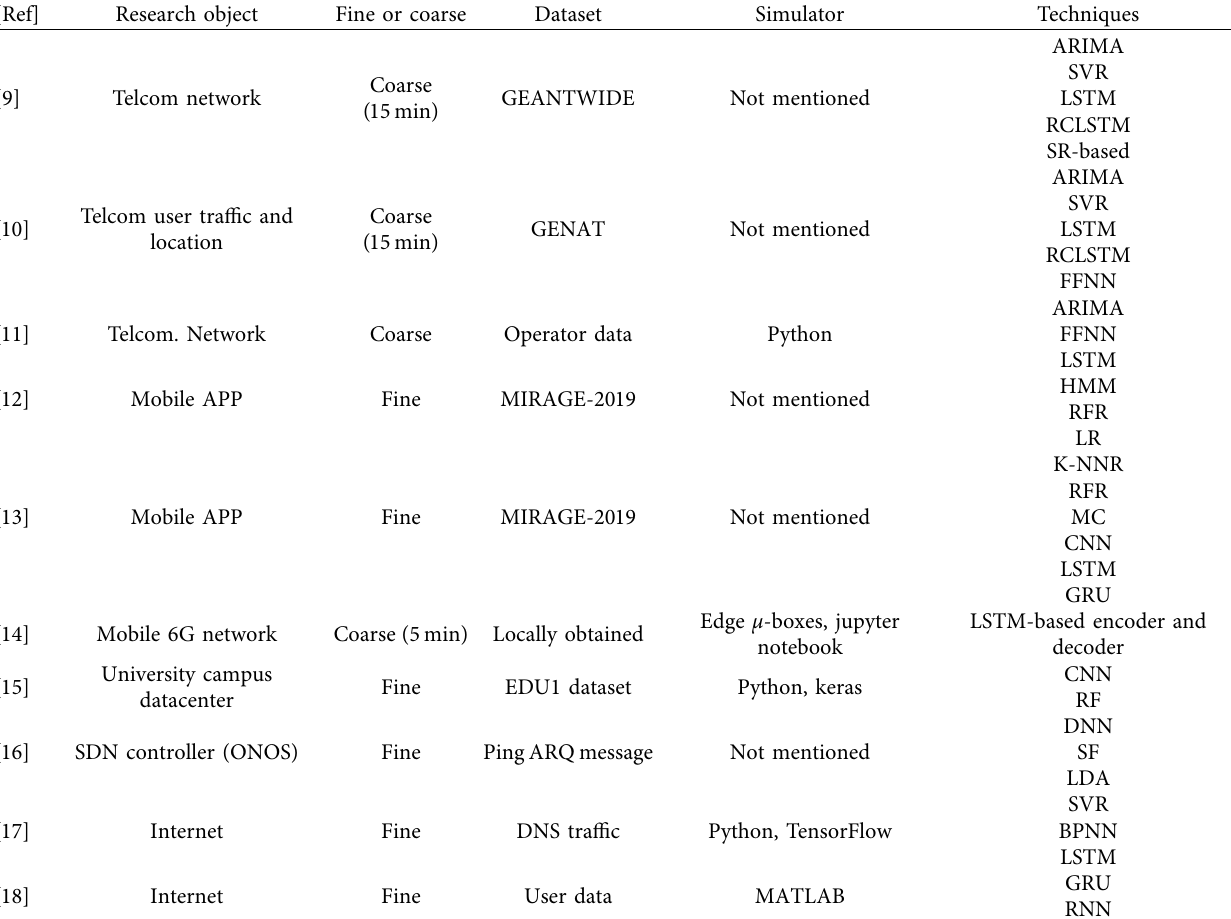
Table 1: Related works performing prediction of diferent research objects and by means of diferent techniques. [Ref]